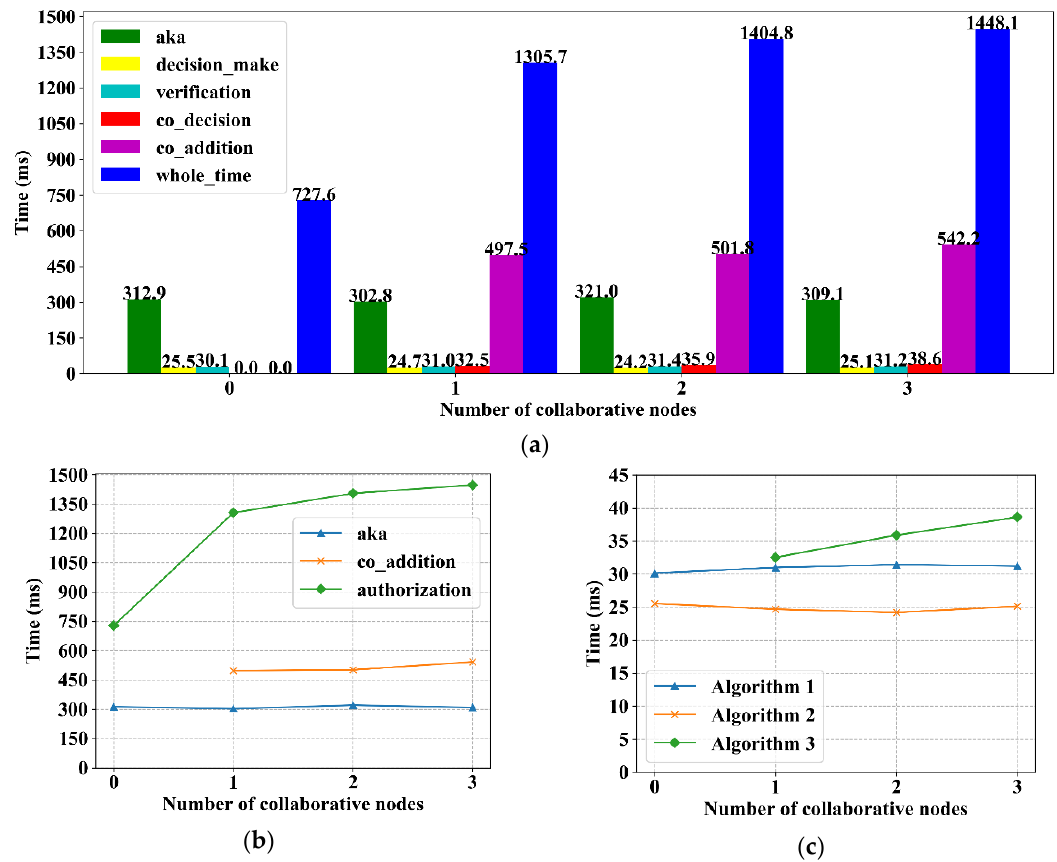
Figure 8. Time cost of our proposed access control scheme: ( a ) an overview of the time cost for our access control scheme; ( b ) the time cost of an authentication and key agreement (AKA), additional time, and the entire access control time; ( c ) the time cost of the three